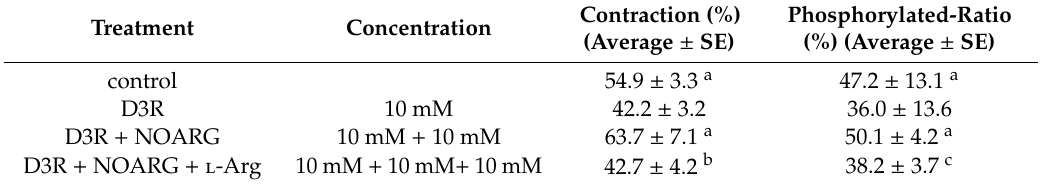
Table 4. Comparison between ET-1 induced ciliary muscle contraction ratio and phosphorylated MLC